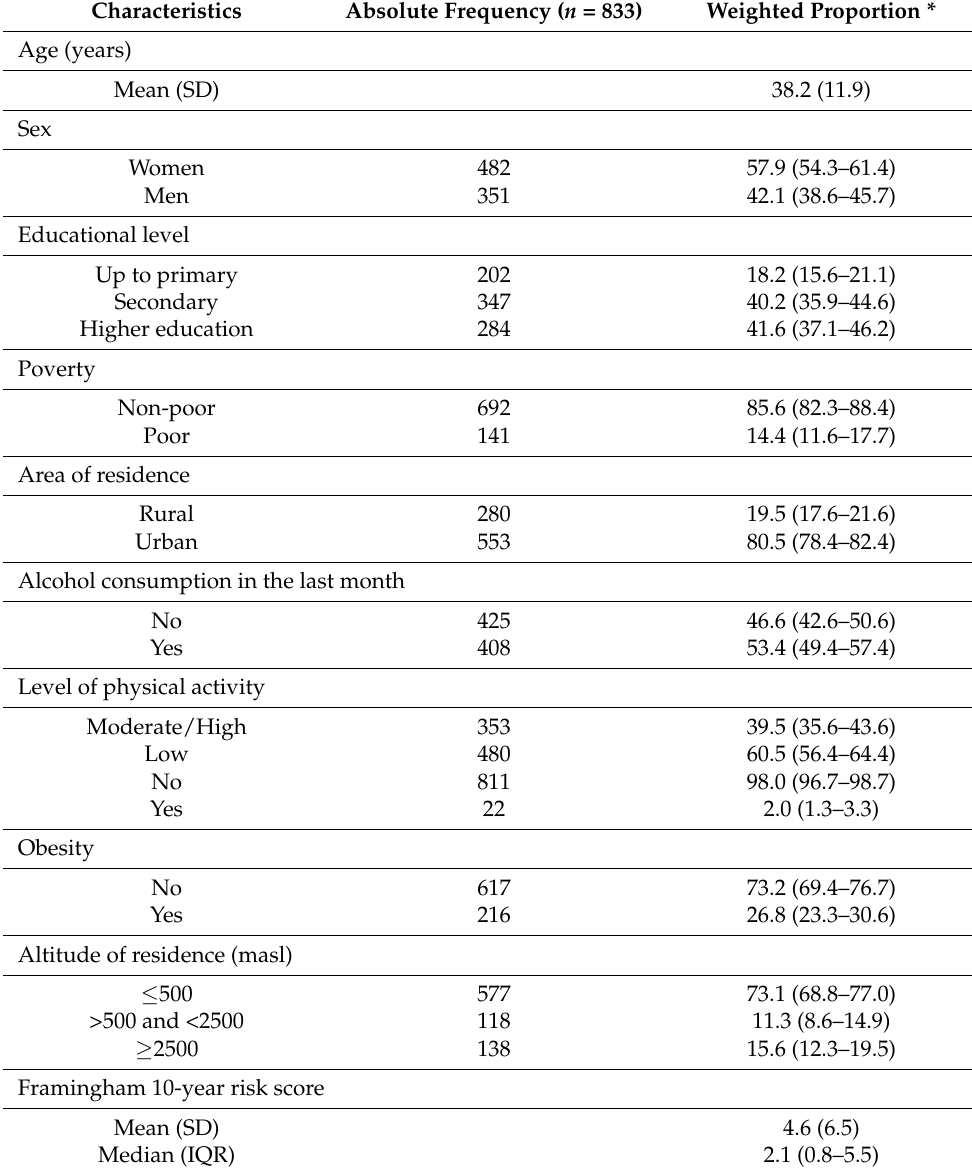
Table 1. Characteristics of the participants included in the